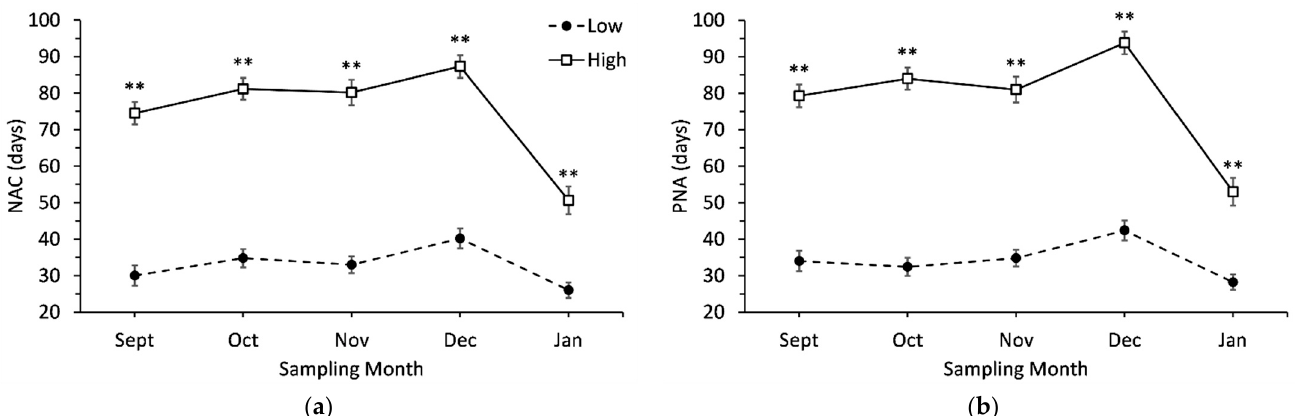
Figure 2. Changes in ( a ) needle abscission commencement (NAC) and ( b ) peak needle abscission (PNA) in low and high NAR balsam fir genotypes over time. Data points are displayed as mean ± standard error as calculated from 10 branches each. The ** indicates 1% significance between genotypes at each month.